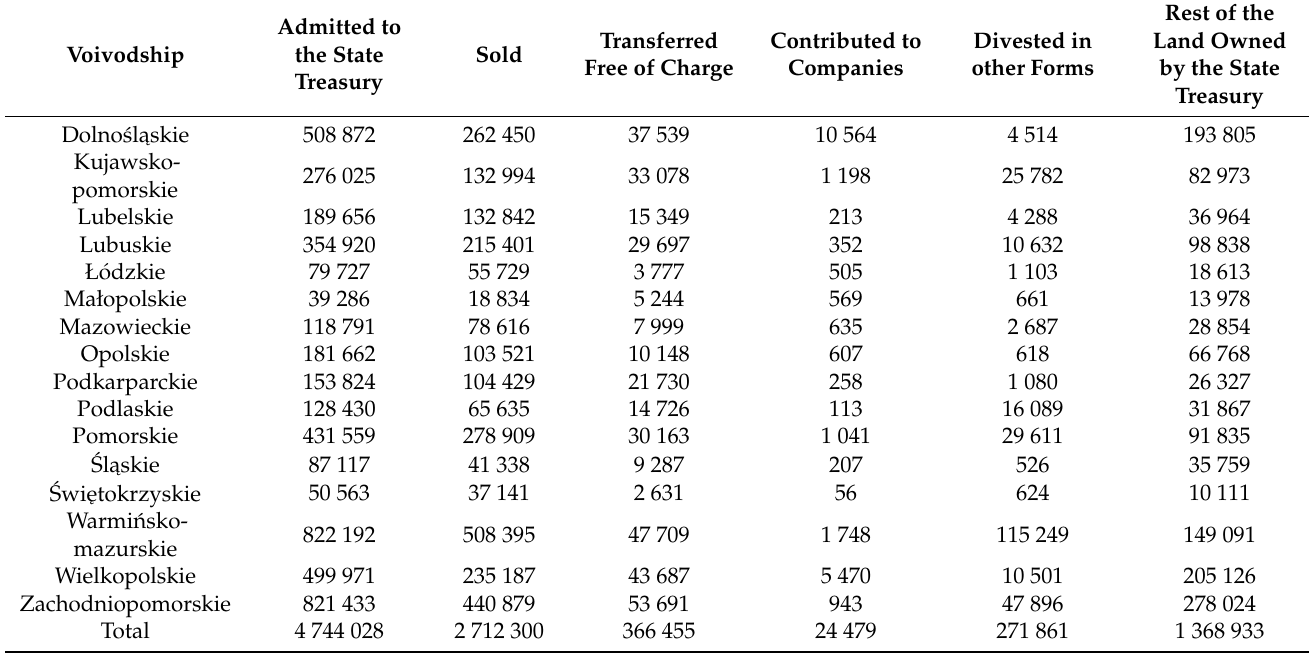
Table 3. Activities of the National Agricultural Support Centre in the field of land management of the land owned by the State Treasury until